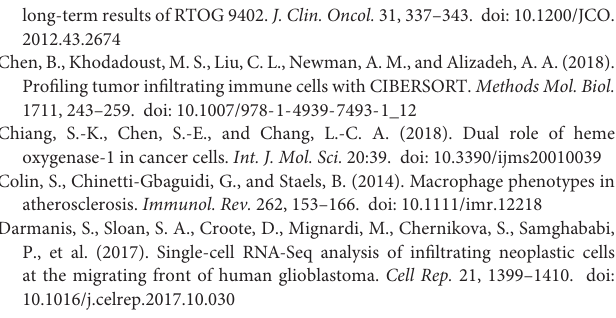
Supplementary Figure 1 | Flow chart of the whole study. FDR, false discovery rate; LASSO, least absolute shrinkage and selection operator. Supplementary Figure 2 | The comprehensive illustration of HMOX1 expression in different tissues and cell types downloading from the HPA database (https://www.proteinatlas.org/). (A) The expression of HMOX1 in normal tissues. (B) The expression of HMOX1 in normal cells (including single cells). (C) The expression of HMOX1 in tumor tissues. (G) The expression of HMOX1 in cell lines. Supplementary Figure 3 | Mutational profiles of HMOX1 . (A) Summary of HMOX1 mutations in TCGA pan-cancers. (B) The general mutation count of HMOX1 . (C,D) Differential altered genes between HMOX1-altered and HMOX1-unaltered groups in pan-cancer and LGG cohort. * p < 0.05. CNV, copy number variation. Supplementary Figure 4 | (A) CNV distribution of HMOX1 in LGG tumor samples. (B) Spearman correlation between HMOX1 CNV and mRNA expression in LGG. (C–F) Correlations between HMOX1 and M2b macrophage markers. (G) Correlations between HMOX1 expression and recognized immune checkpoints. ∗ p < 0.05, ∗∗ p < 0.01, ∗∗∗ p < 0.001. CNV, copy number variation; Homo. Amp., homogenous amplification; Homo. Del., homogenous deletion; Hete. Amp., heterogenous amplification; Hete. Del., heterogenous deletion. Supplementary Figure 5 | Prediction of drug responses in the (A) Cancer Cell Line Encyclopedia (CCLE), (B) Cancer Therapeutics Response Portal (CTRP), and (C) Genomics of Drug Sensitivity in Cancer (GDSC) banks. * p <